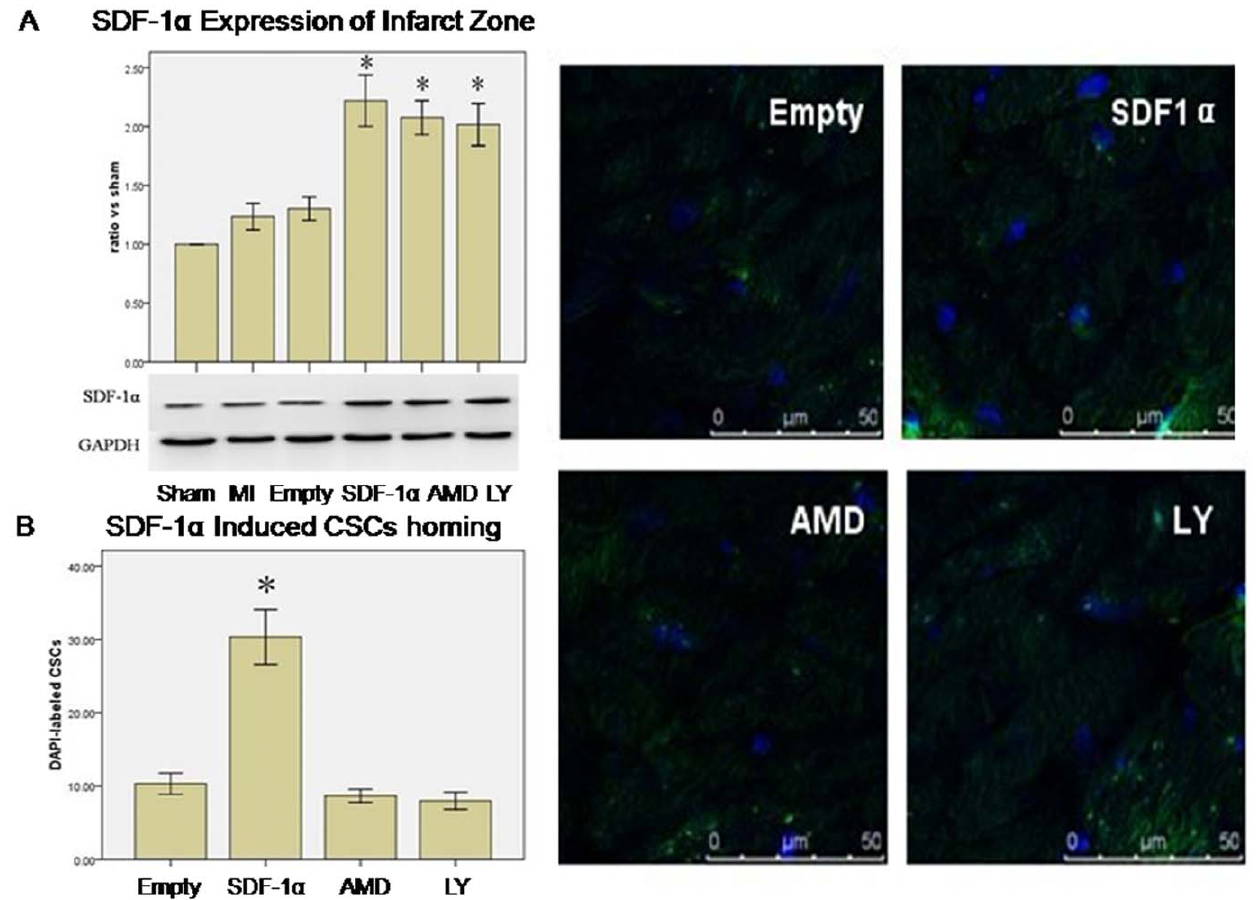
Figure 3. SDF-1 a /CXCR4 induced CSCs homing via PI3K pathway. A . Western blotting analysis of SDF-1 a expression in the infarcted zone 3 weeks after coronary artery ligation or sham operation (the ratio of SDF-1 a expression vs. Sham group). * p , 0.05 vs. Sham, MI and Empty (vector) group. GAPDH served as an internal control. Data were shown as mean 6 SD. n=3. B . SDF-1 a Induced the CSCs Homing. Overexpression of SDF-1 a induced DAPI-labeled CSCs homing to the infarcted zone. This effect was inhibited by AMD3100 and LY294002 pretreatment. * p , 0.01vs. Empty, AMD(AMD3100) and LY(LY294002) group. Results were shown as mean 6 SD, n=6.